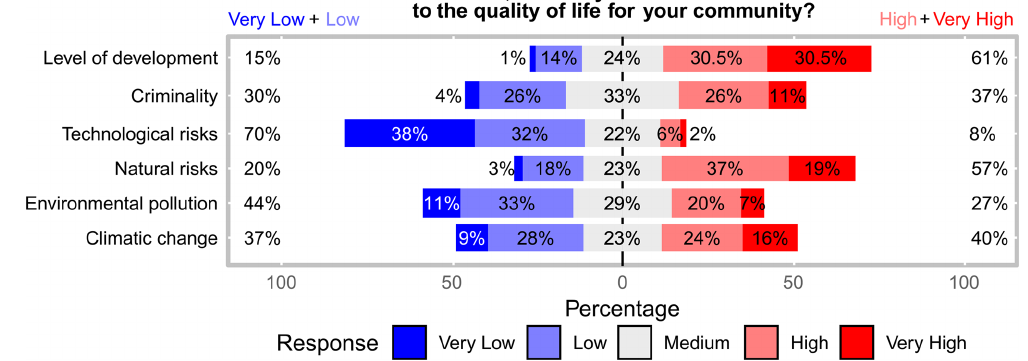
Figure 2. The Likert plot of the stakeholders’ responses regarding the perception of the factors that can threaten the local community.